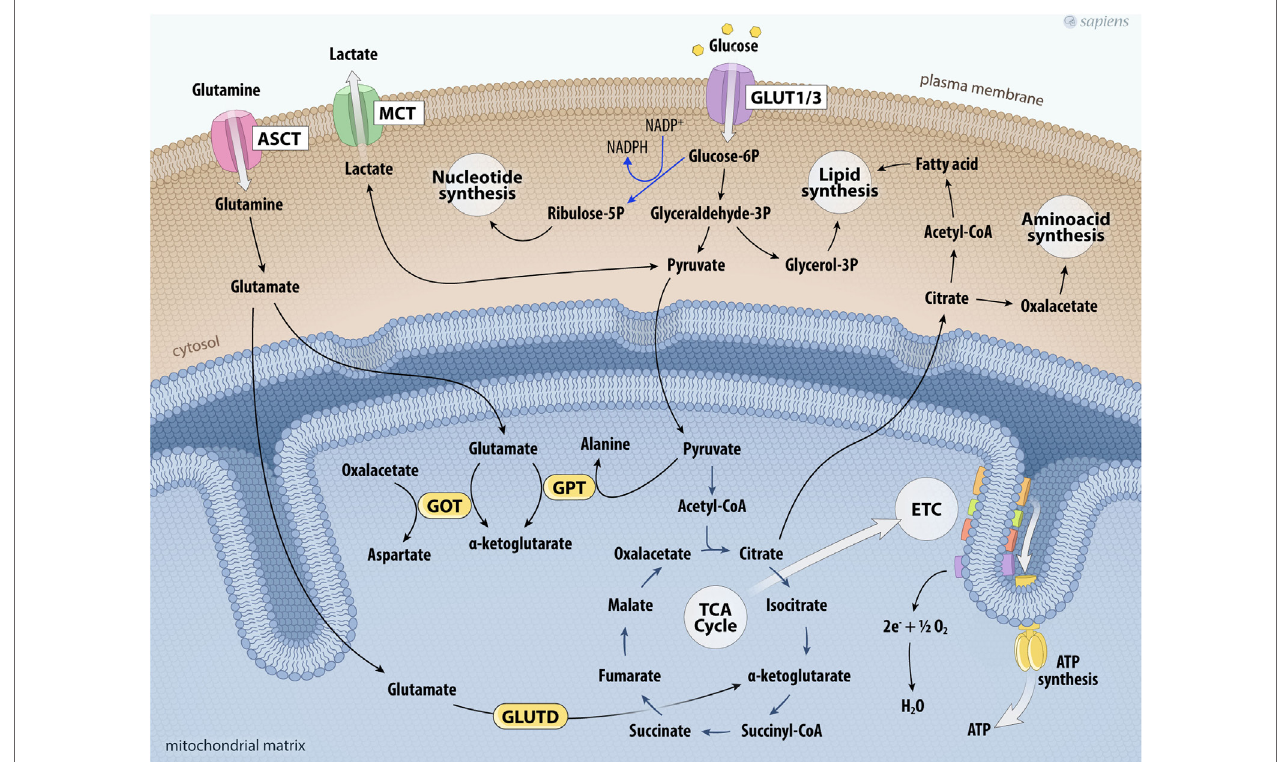
FiGURe 2 | Glutaminolysis and glucose metabolism in cancer cells. The higher glycolytic pathway contributes not only to the production of ATP per glucose consumed, but also feeds other biosynthetic pathways. Deviation of glyceraldehyde-3P to glycerol-3P is important for lipogenesis. Glucose-6P can also shift toward the phosphate pentose pathway that provides ribulose-5-phosphate and NADPH to nucleotide synthesis. On the other hand, glutamine uptake maintains the anaplerotic process in the TCA cycle. Glutamine is taken up via the transporter ASCT and is converted into glutamate. Glutamate together with pyruvate can be metabolized by GPT producing α -ketoglutarate and alanine; glutamate is metabolized producing α -ketoglutarate and aspartate by GOT; or glutamate is metabolized by glutamate dehydrogenase (GLUTD) forming α -ketoglutarate. All these reactions contribute to support the TCA cycle. Citrate outside mitochondria contributes to the de novo formation of fatty acids and aminoacids. Cancer cell metabolism is also characterized by the upregulation of lactate dehydrogenase to facilitate the conversion of pyruvate to lactate, which is then secreted to the tumor microenvironment via the MCT. Abbreviations: ASCT, Asc-type amino acid transporter; ETC, electron transport chain; GLUT1/3, glucose transporter 1 or 3; TCA, tricarboxylic acid; GOT, glutamate-oxaloacetate transaminase; GPT, glutamate–pyruvate transaminase; MCT, monocarboxylate